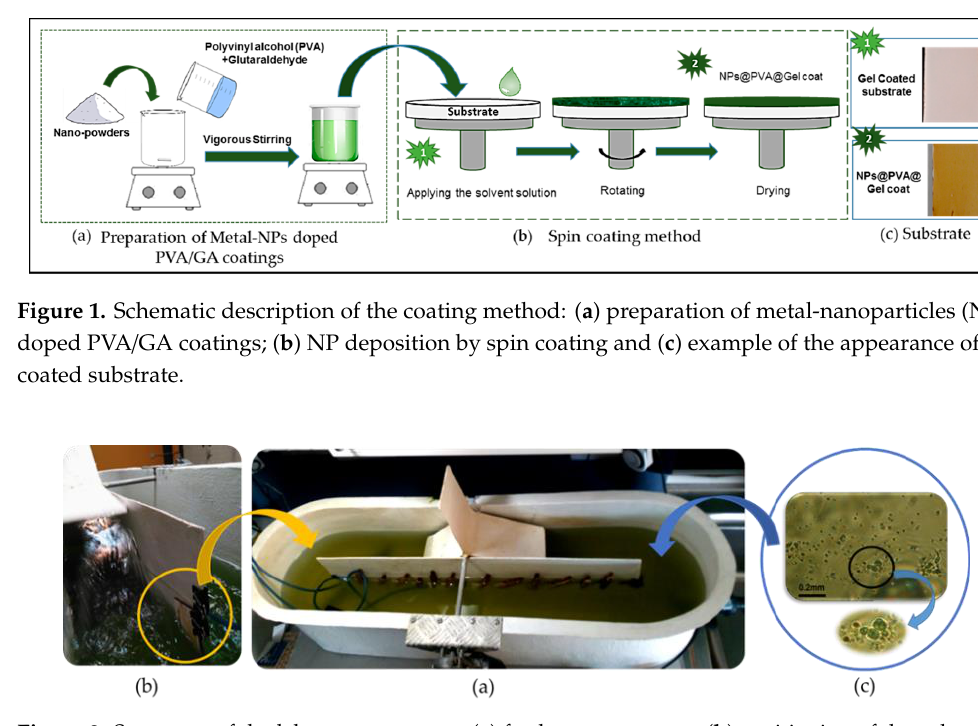
Figure 2. Summary of the laboratory raceway ( a ) freshwater raceway; ( b ) positioning of the substrates in the raceway and ( c ) optical microscopy of a culture of Coelastrella microalgae.